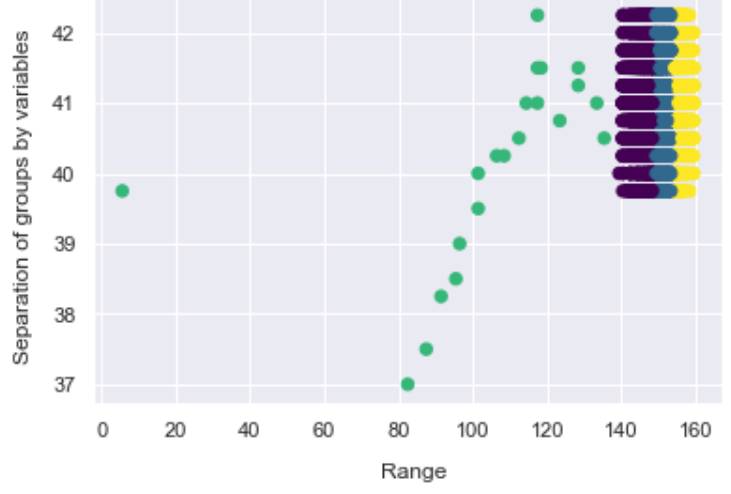
Figure 20. GMM distribution of the 4 classes on the bracelet.